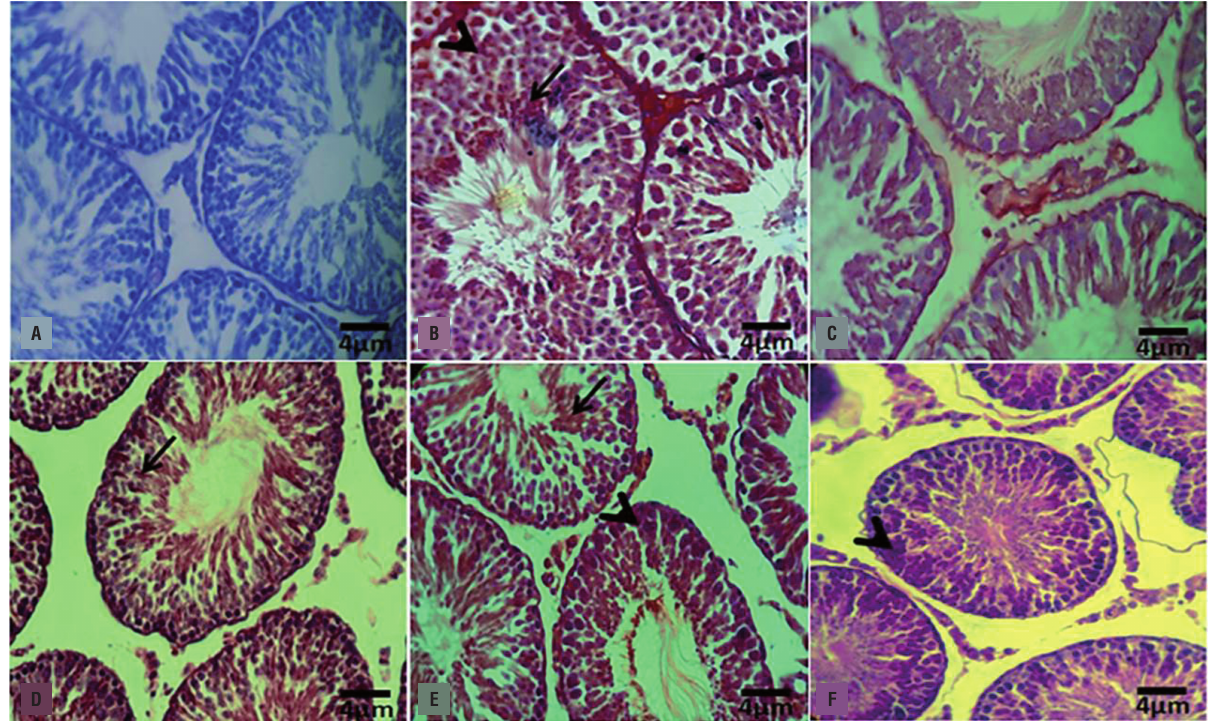
Figure 6 - Immunohistochemical analyses for Hsp70-2. (A) negative control; (B) control-sham: intensive Hsp70-2 expression is presented in pachytene spermatocytes (head arrow) and in the cell in spermiogenesis process (arrow); (C) VCL-induced group: the germinal cells are exhibited with remarkable reduction in Hsp70-2 expression; (D) VitE-treated group; (E) DEX-received group; and (F) VitE+DEX-administrated group: the Hsp70-2 expression was back to control condition, which the spermatocyte (head arrow) and spermatids (arrow) are presented with up regulated Hsp70-2 expression. Immunohistochemical staining for